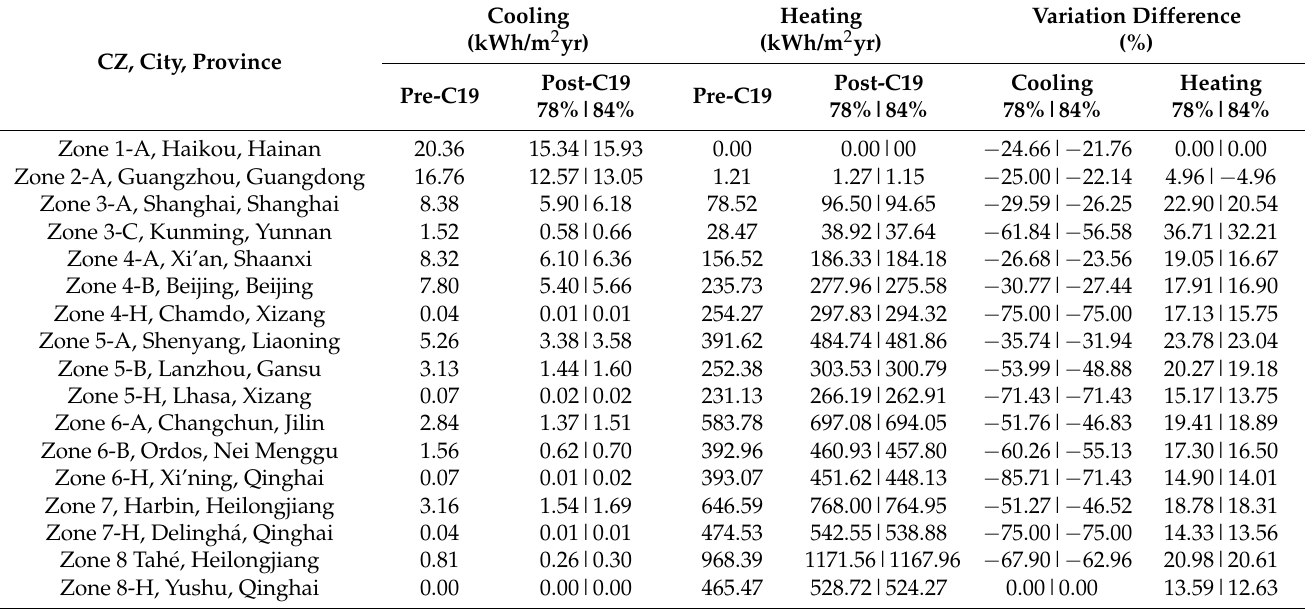
Table 11. Cooling and heating EUI per location in pre- and post-C19